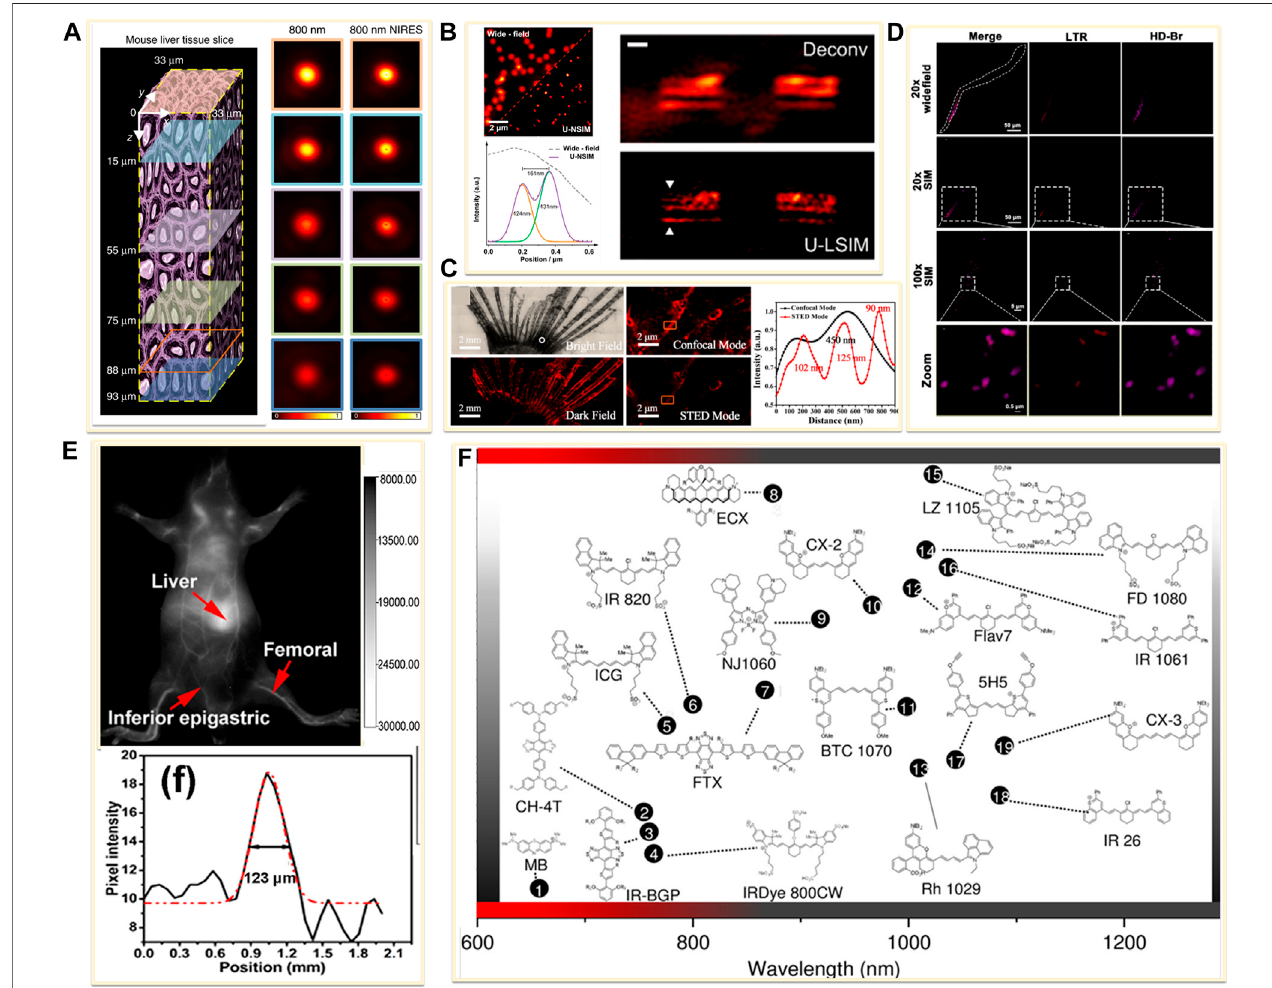
FIGURE7| Examplesofnear-infrared fl uorescentprobesfor invivo imaging. (A) Left:diagramofamouselivertissueslicewith93 µmthickness(Chenetal.,2018). Right: confocal images and the corresponding near-infrared emission saturation images from 800 nm emission at different depth in liver tissue. Reprinted from Chen et al. (2018) with permission from Springer Nature. (B) Left: super-resolution images of the 4% Tm-doped Upconversion nanoparticles (UCNPs) (Liu et al., 2020). Right: comparison of Wiener deconvolution and upconversion nonlinear SIM (U-LSIM) image of the a 51.5 μ m liver tissue slice. Scale bar: 1 μ m. Reprinted from Liu et al. (2020)withpermissionfromAmericanChemicalSociety. (C) Anenlargedbrightviewanddark fi eldofglasscat fi shstainedby fl uorescentorganicnanoparticles(FONPs), and the corresponding confocal and STED images (Xu Y. et al., 2020). Reprinted from Xu Y. et al. (2020) with permission from American Chemical Society. (D) SIM imagingofC.eleganslabeledwithLyso-TrackerRed(LTR)anddevelopedsmallmoleculedyeHD-Br(Fangetal.,2019).ReprintedfromFangetal.,2019withpermission from American Chemical Society. (E) Image showing a live mice in supine position after tail injection of C18-PMH-PEG-Ag2Se QDs (Dong et al., 2013). Reprinted from Dongetal.(2013)withpermissionfromAmericanChemicalSociety. (F) RepresentativeNIR-IIdyesusedfor invivo imaging(LeiandZhang,2020).ReprintedfromLeiand Zhang (2020) with permission from John Wiley and